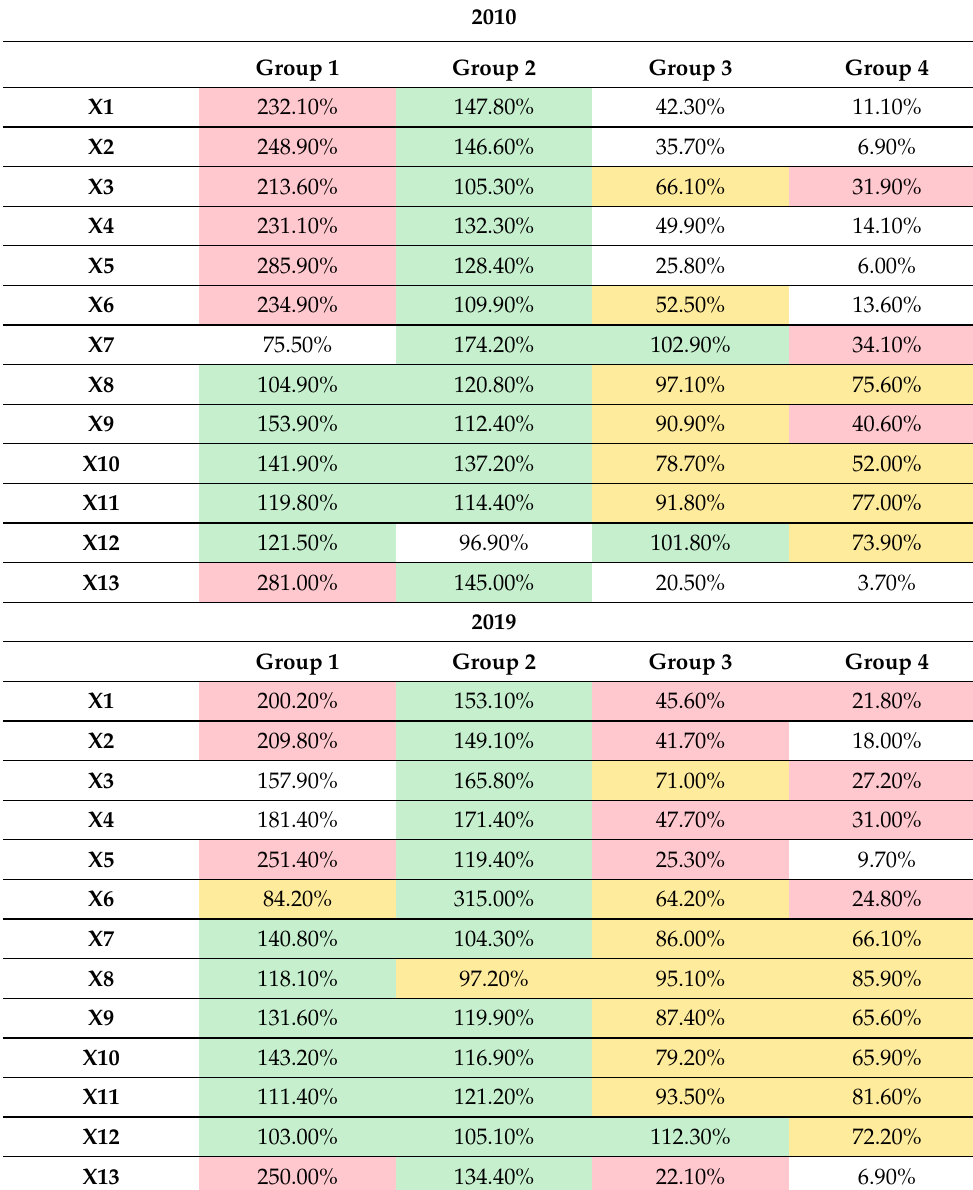
Table 8. The ratio of the group average to the total average in 2010 and